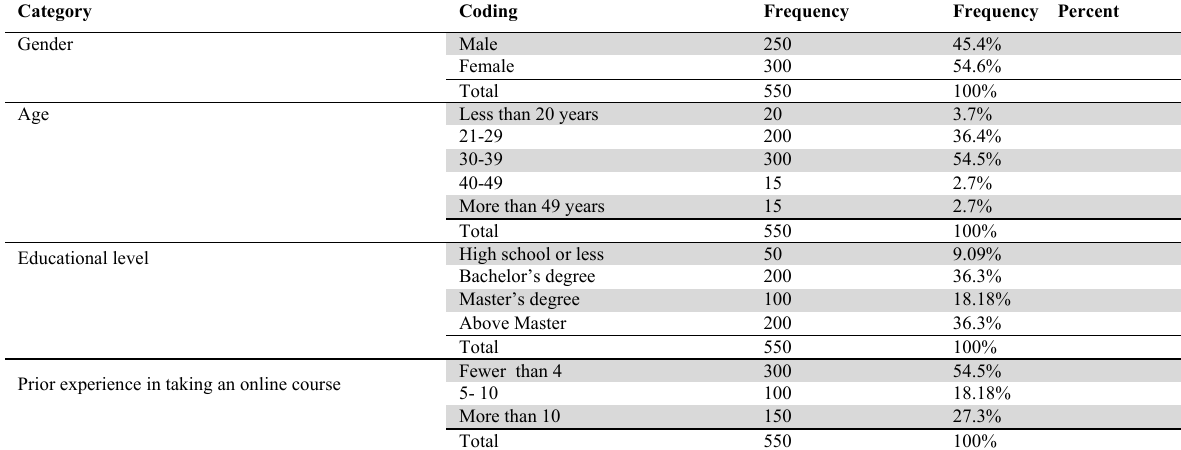
Demographic Characteristics of